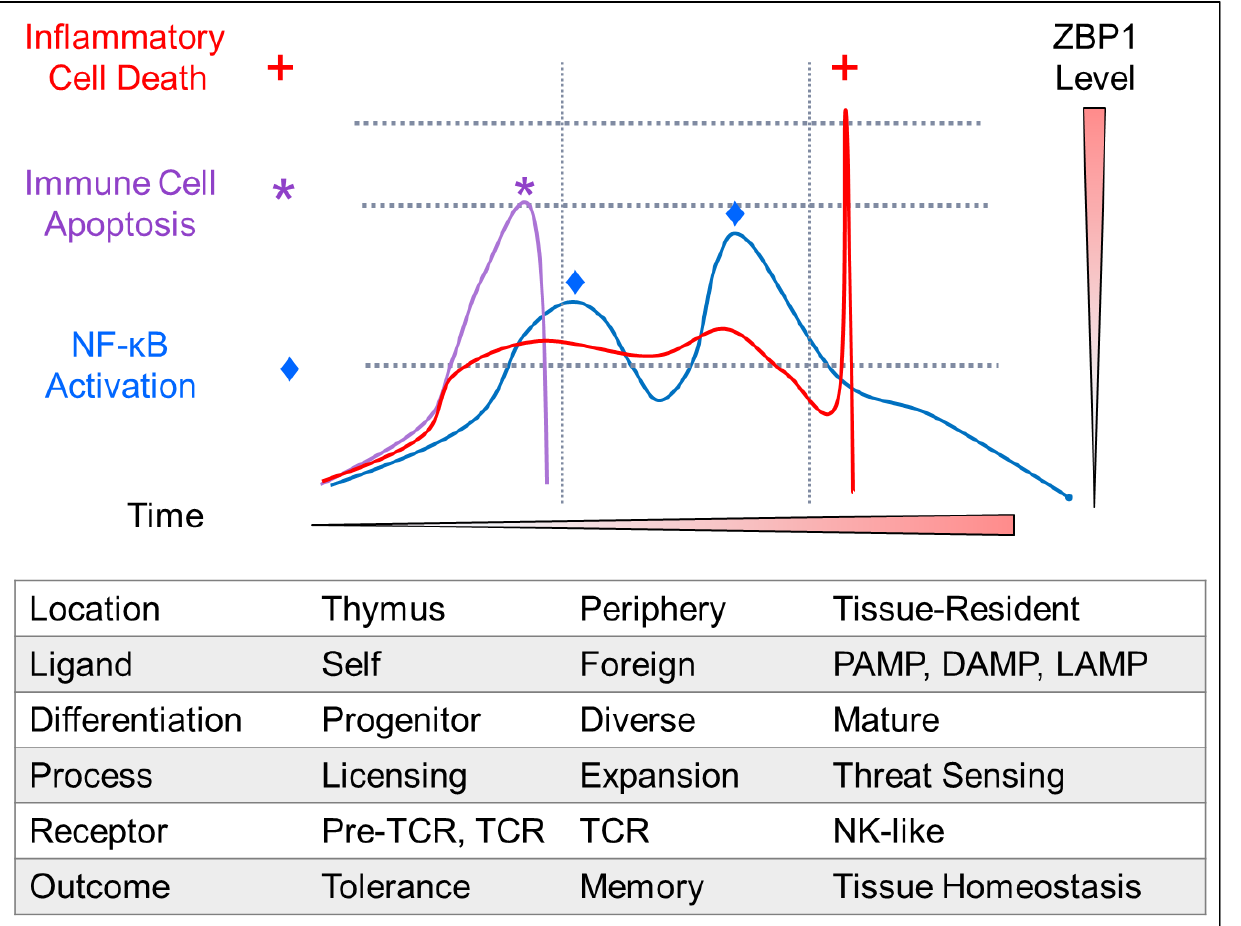
Figure 3. A proposed timeline for immune cell development highlighting different roles for ZBP1 in protecting against threats. Early in development, ZBP1 is able to protect against reactivation of endogenous retroelements and aberrant regulation of transcription by sensing the dsRNA involved and inducing apoptosis (indicated by * ). Late in development, ZBP1 expressed by tissue-resident immune cells can activate necroptosis (indicated by + ) when pathogen associated molecular patterns (PAMPs), damage associated molecular patterns (DAMPs) or live-style associated molecular patterns (LAMPs) are detected. The inflammatory cell death clears space for responding T cells to eliminate the threat. NF- κ B is activated by ZBP1 during an adaptive immune response (shown by (cid:7) ). 4. Are “Exhausted” T Cells Actually Highly Functional